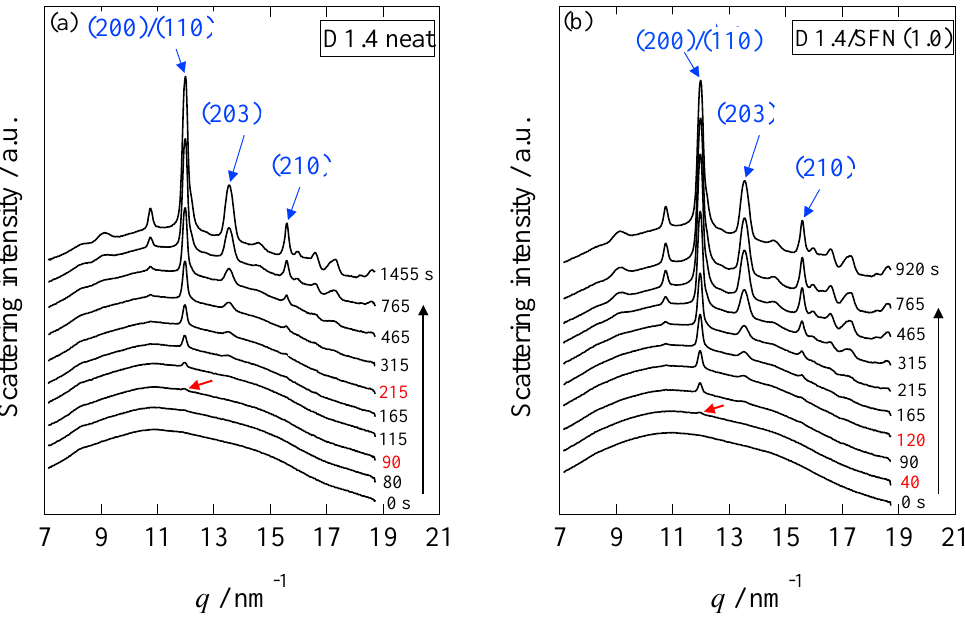
Figure 1. Time-resolved wide-angle X-ray scattering (WAXS) profiles of ( a ) D1.4 neat ( b ) D1.4/SFN(1.0) specimens. The red arrow indicates the first detection of the peak.